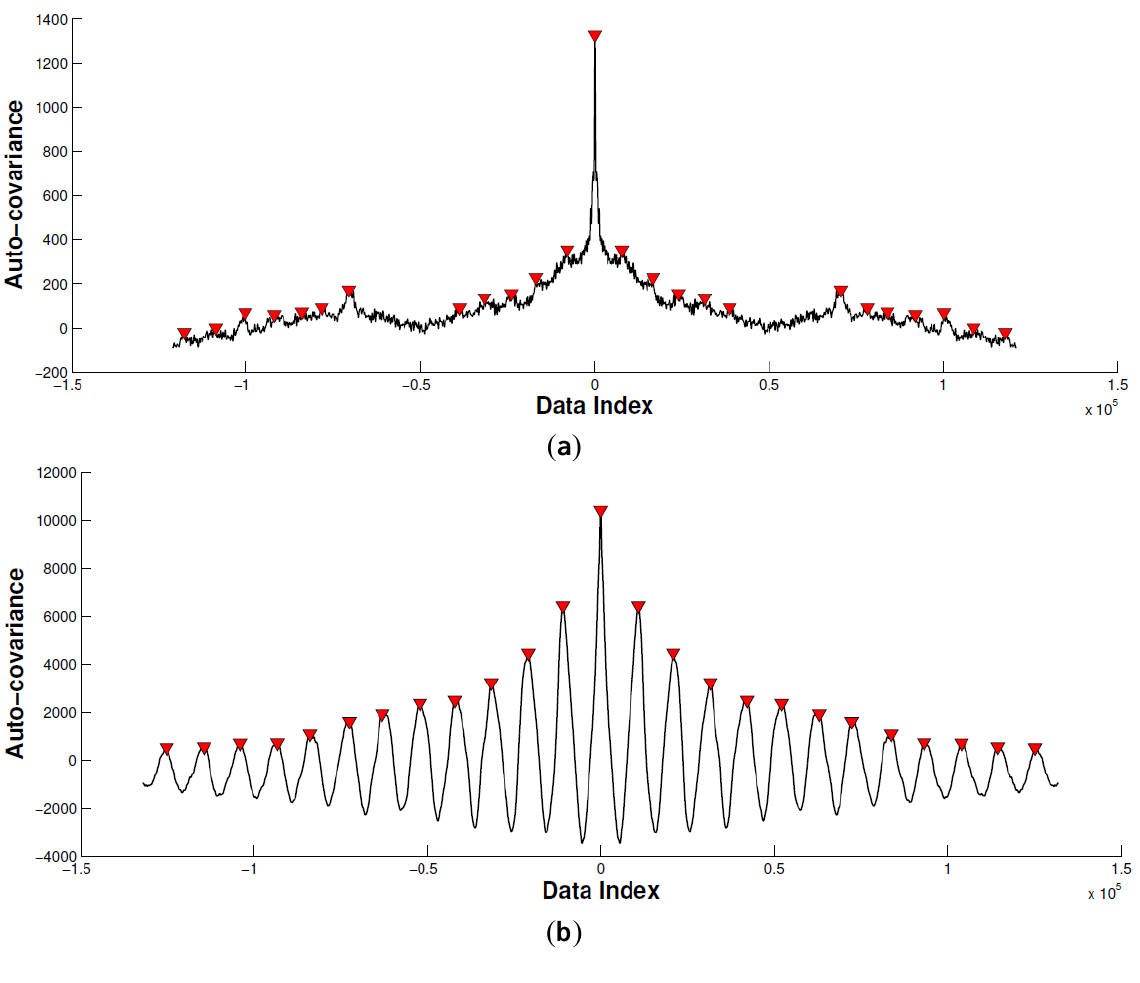
Figure 7. Self-correlation of the acceleration signal corresponding with biceps brachii. ( a ) Experiment 1. ( b ) Experiment 2. In Experiment 1, as the difference between the